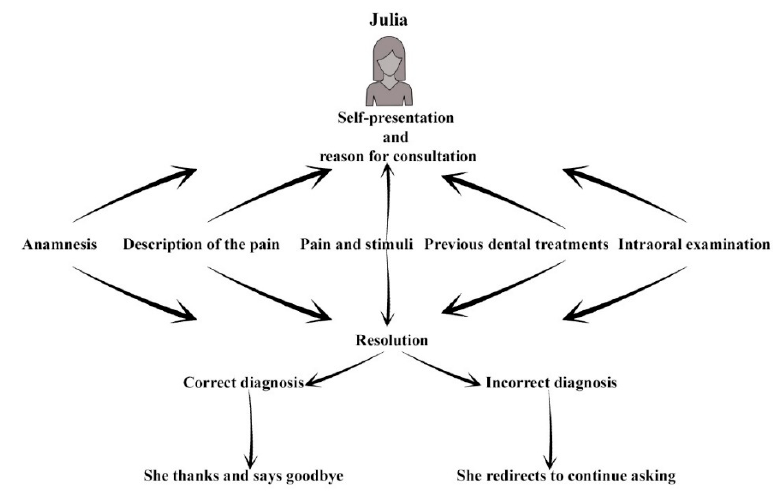
Figure 2. Chatbot conceptualization diagram. Table 1. Example of the expressions for a question about Julia’s response if heat is applied with a corresponding answer.